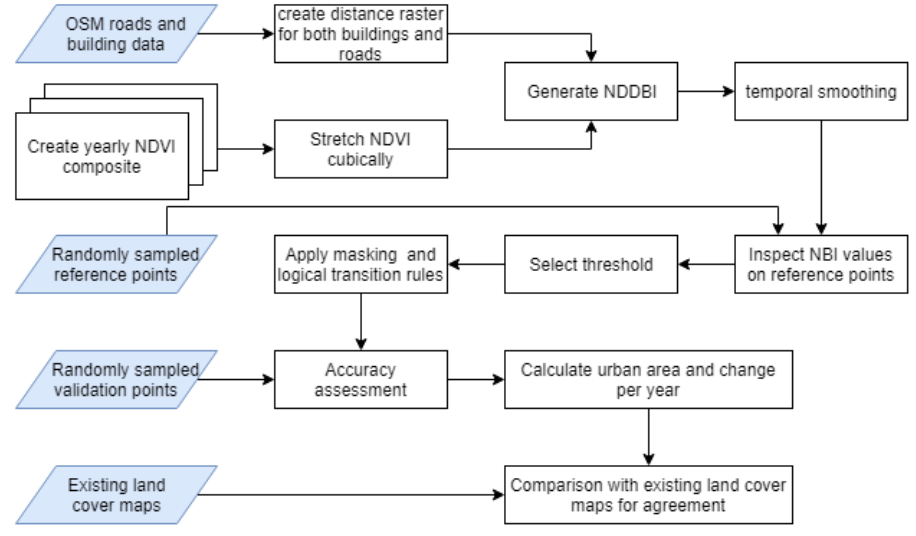
Figure 2. Overall methodology of the